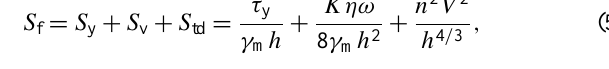
Table 1. Moraine parameter values used in the breaching equations. Parameter Moraine height ( h d ,